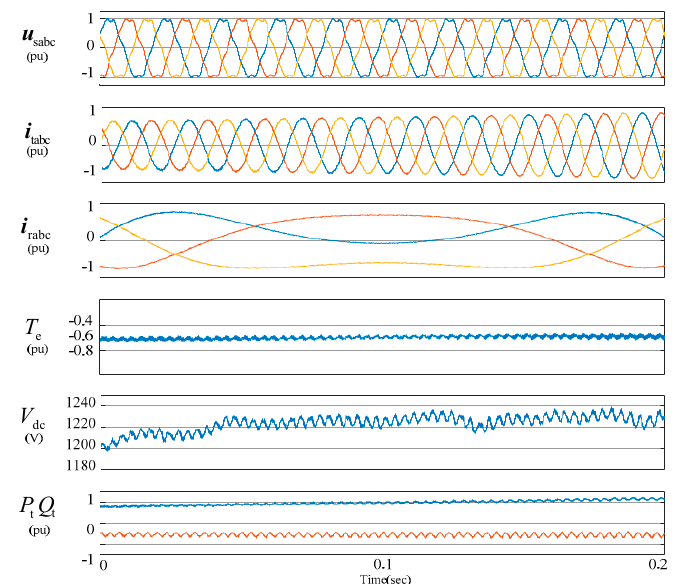
Figure 11. Simulation results of the MRSMC with continuous variation of rotor speed.